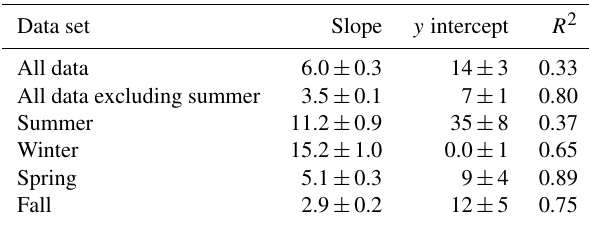
Figure 10. Correlation of nssSO 4 with MSA concentrations ob- served at Concordia on HV bulk aerosol samples. (a) All data (red circles highlight mid-summer samples); (b) spring to fall samples. Table 4. Slope and y intercept ( ± standard error estimate) of the linear regression between nssSO 2 − and MSA levels as a function 4 of season at